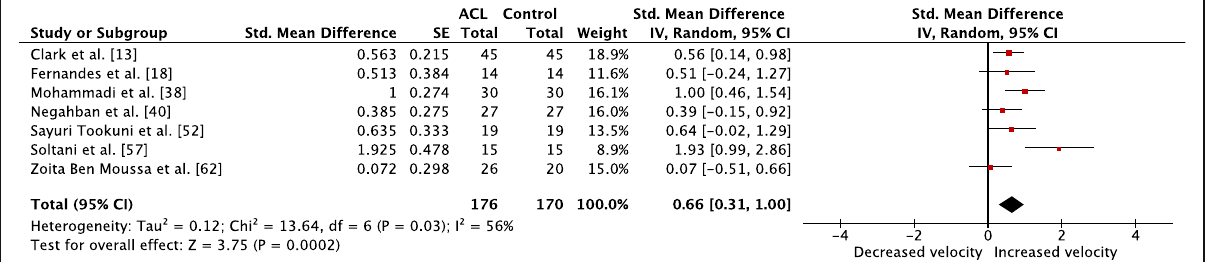
Fig. 5 Forest plot comparison of sway velocity between the ACL-injured and ACL-matched control leg. Std . standardized, SE standard error, IV in- verse variance, CI confidence interval, df degrees of freedom, ACL anterior cruciate